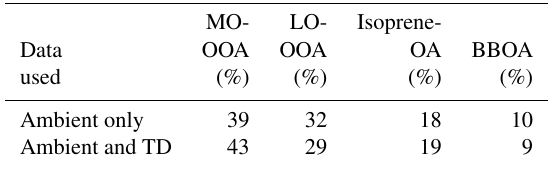
Table 2. OA mass fractions of the ambient and ambient and TD PMF factors. MO-